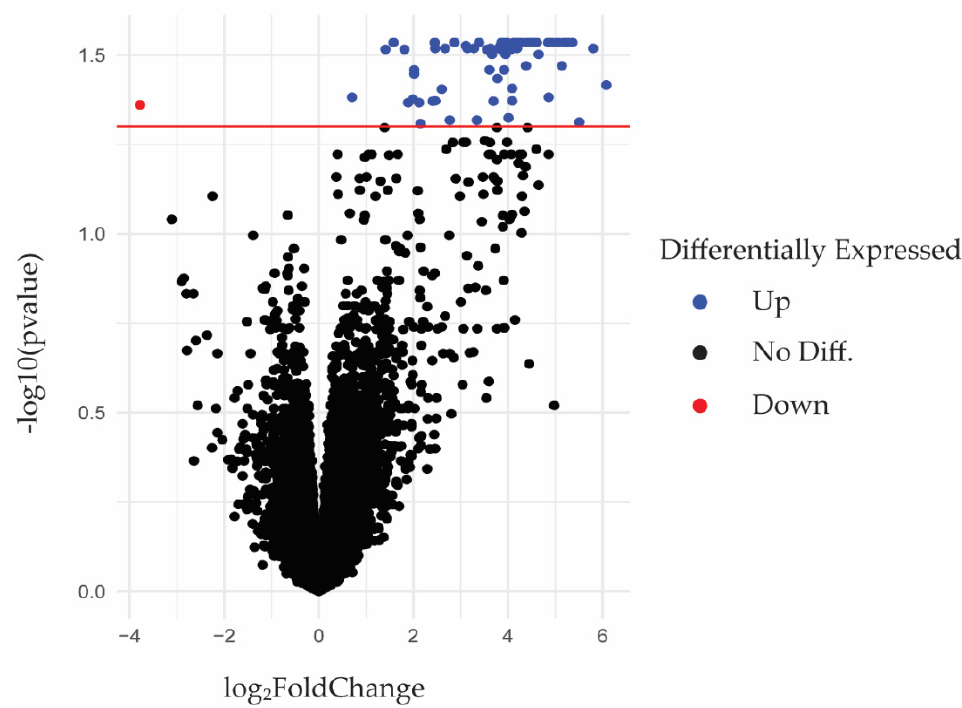
Figure 1. Volcano Plot of all differentially expressed genes (DEGs). The x -axis shows the log 2 fold- change value for each gene, with positive and negative values representing up- and downregulation, respectively. The y -axis shows the − log 10 adjusted p -value for each gene, with more significant values located higher on the y -axis. Base log 2 and log 10 were used on the x - and y -axis, respectively, to help visualize DEGs with very large or small fold changes and adjusted p -values. Significant DEGs are labeled as either red (downregulated genes; Down) or blue (upregulated genes; Up) dots and were determined according to the criteria adjusted FDR-adjusted p -value < 0.05. The horizontal red line shows the 0.05 adjusted p -value cutoff. All fold-change values were considered if the adjusted p -value was below 0.05. Seventy-seven DEGs were upregulated, and one gene (C1orf68) was downregulated in periodontal disease gingiva. Table 2. Top 22 DEGs identified in periodontal disease gingival tissue.